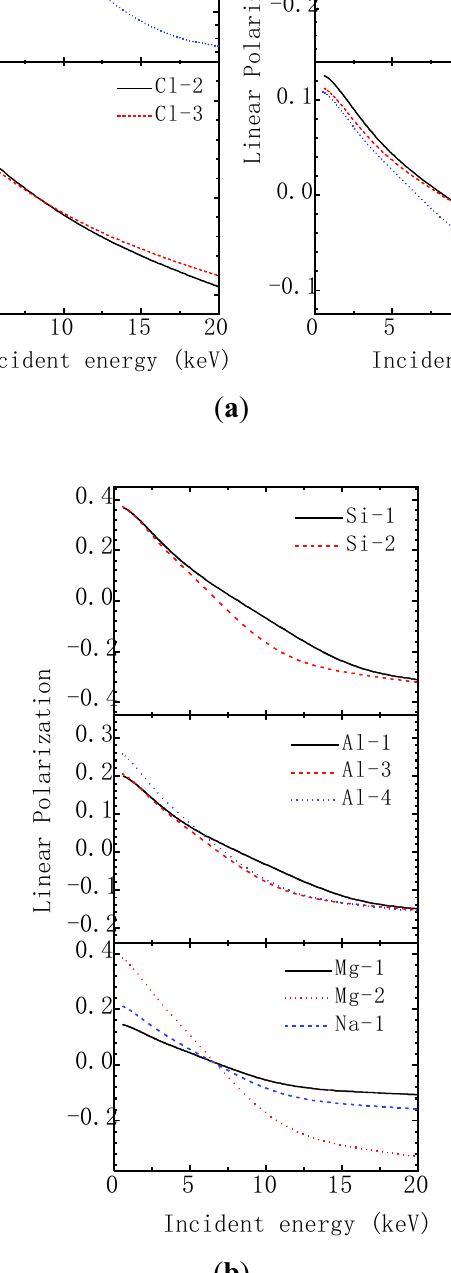
Figure 3. ( a ) Polarization for the photon emission from anisotropic excited states through different transitions (as given in Table 6) for K-like, Ar-like, Cl-like, S-like and P-like tungsten ions as a function of incident electron energy; ( b ) Polarization for the photon emission from anisotropic excited states through different transitions (as given in Table 6) for Si-like, Al-like, Mg-like and Na-like tungsten ions as a function of incident electron